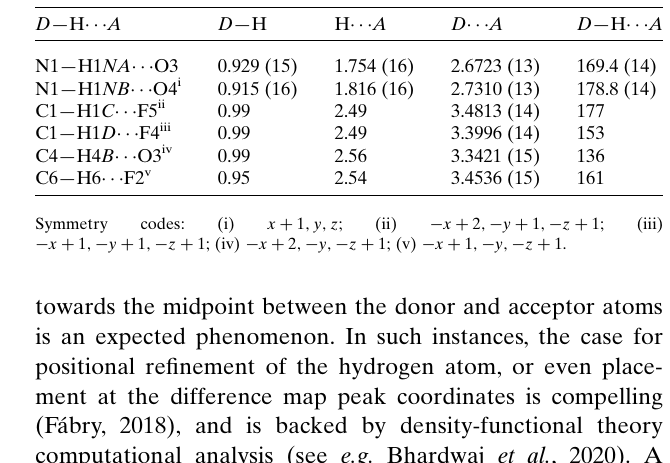
Table 4 Hydrogen-bond geometry (A˚ , (cid:4) ) for IV